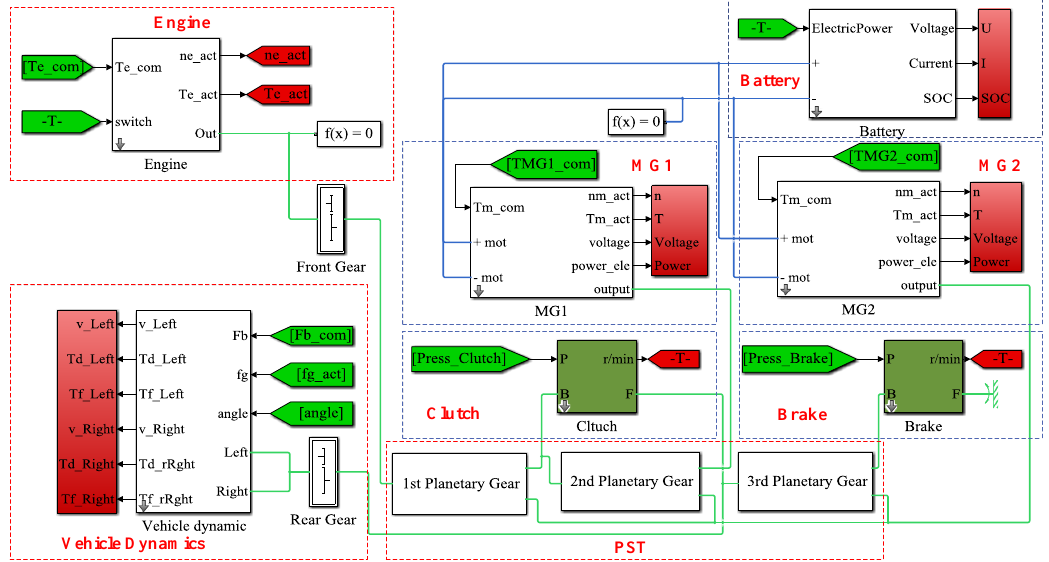
Figure 14. Block diagram of the hybrid HDV in MATLAB/Simulink.